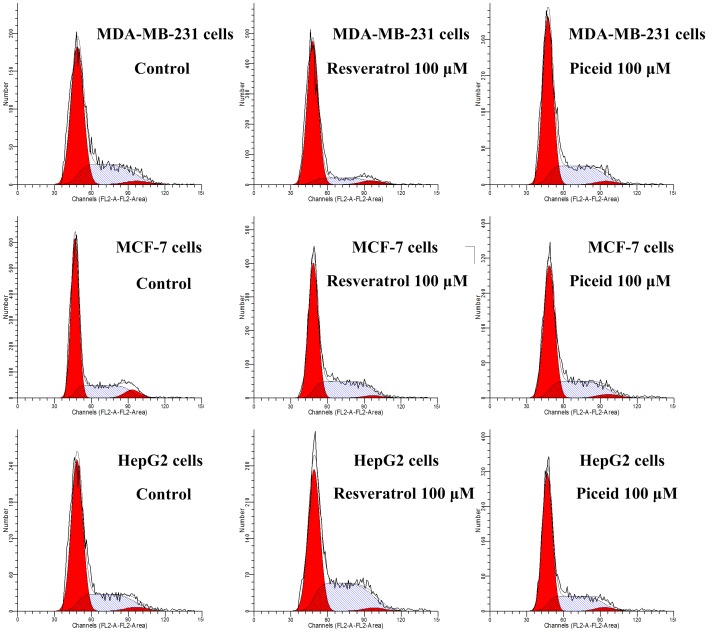
Effects of resveratrol (RES) and piceid (PD) on cell cycle of MDA-MB-231 cells, MCF-7 cells and HepG2 cells.Cultures of MDA-MB-231 cells were treated with varying concentrations of resveratrol and piceid for 24 h. At the end of treatment, cells were trypsinized, incubated with RNase, stained with propidium iodide (PI), and analyzed by flow cytometry. Results shown are of an experiment representative of cell cycle.